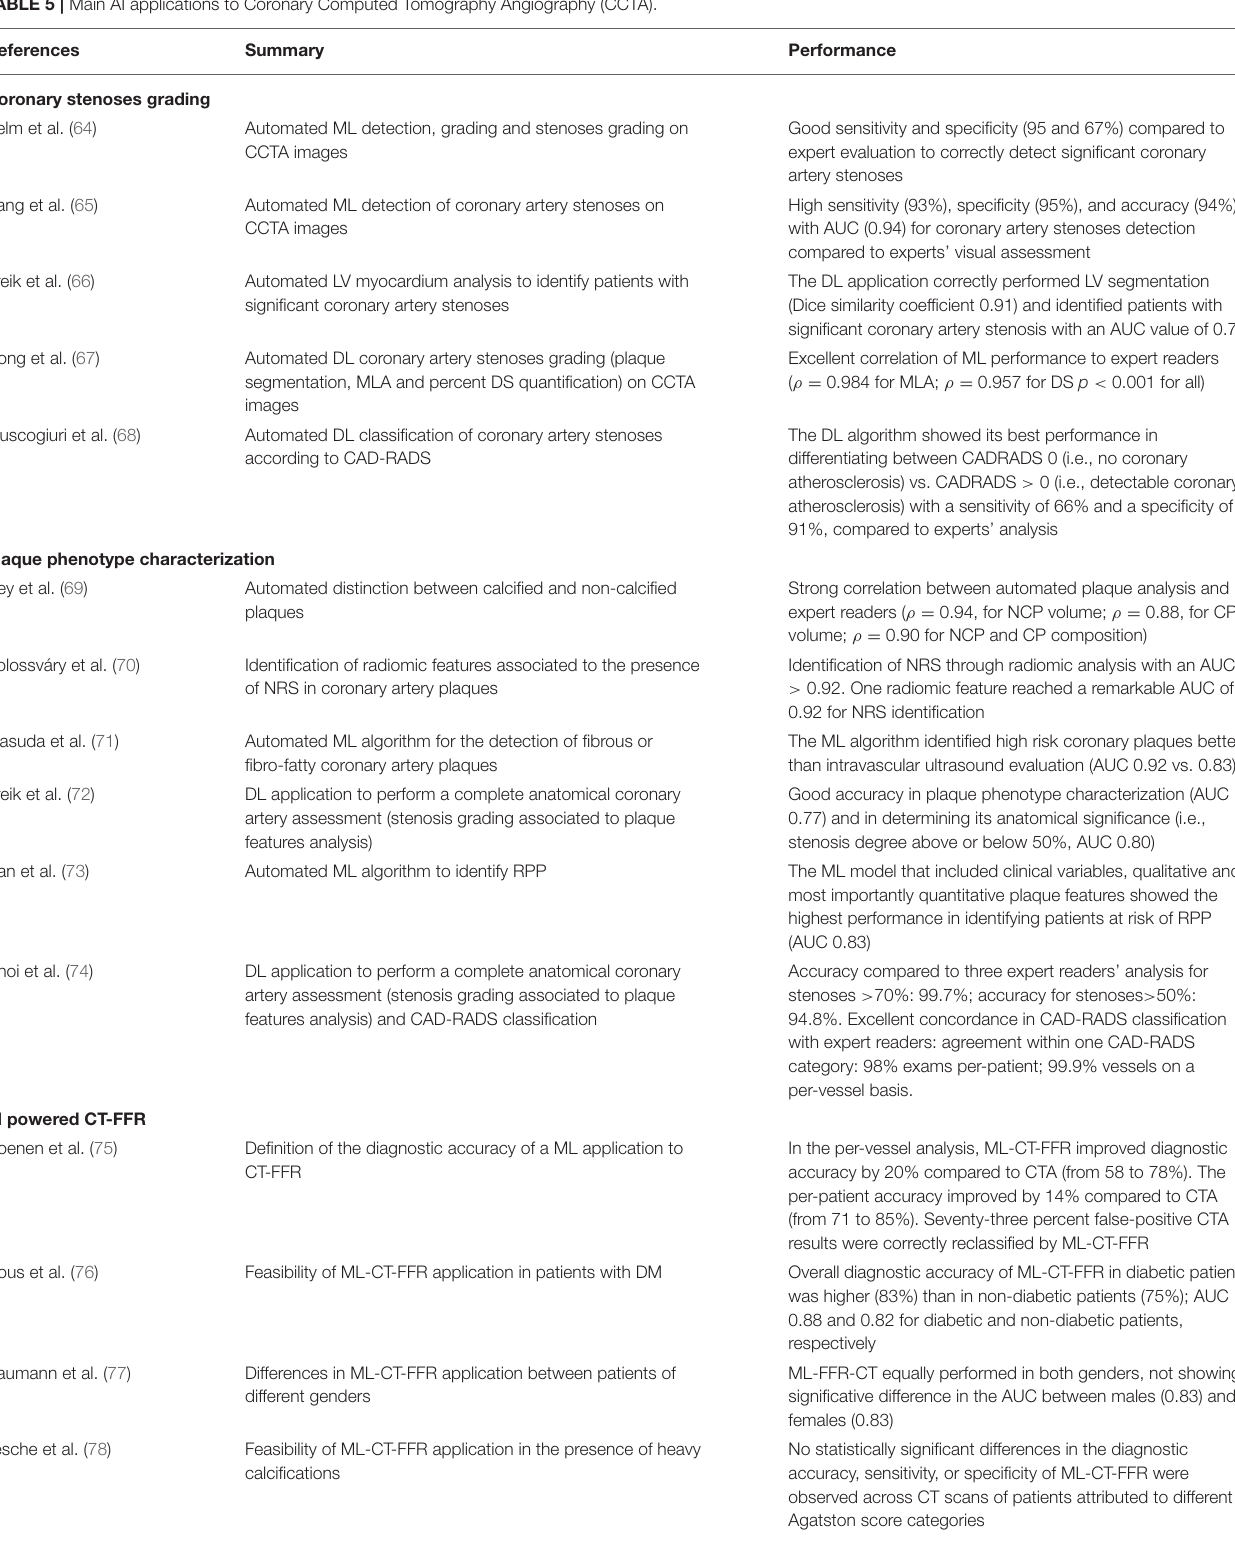
TABLE 5 | Main AI applications to Coronary Computed Tomography Angiography